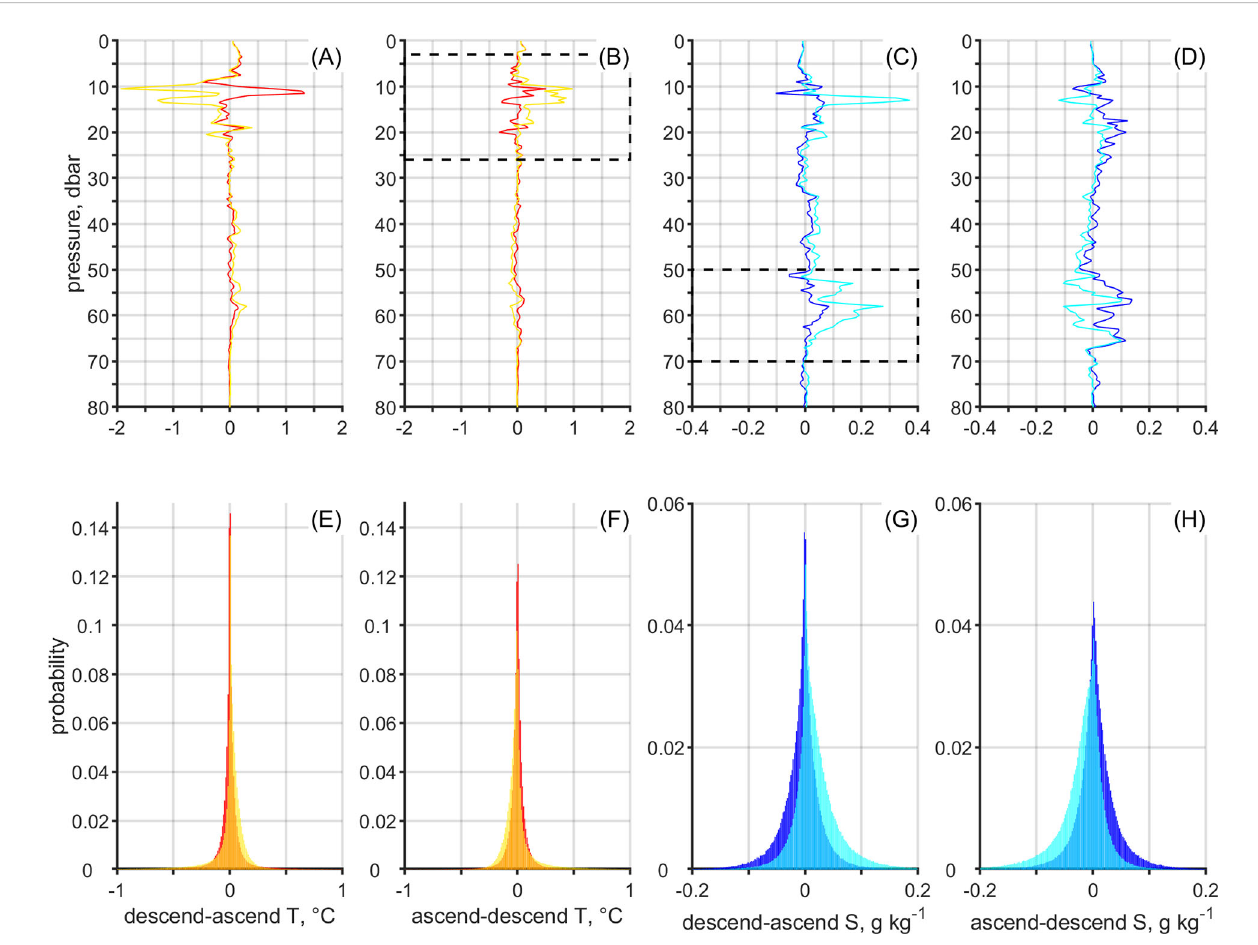
FIGURE 11 (A – D) The discrepancy respectively between two consecutive temperature and salinity pro fi les as shown in Figures 9A – D). The dashed line in the upper part of the water column highlights the thermocline range (B) and in the lower part the halocline range (C) . (E – H) The histogram of discrepancies respectively for all the compared temperature (raw in yellow and corrected in red) and salinity (raw in cyan and corrected in blue) pro fi les in case of descend-ascend and